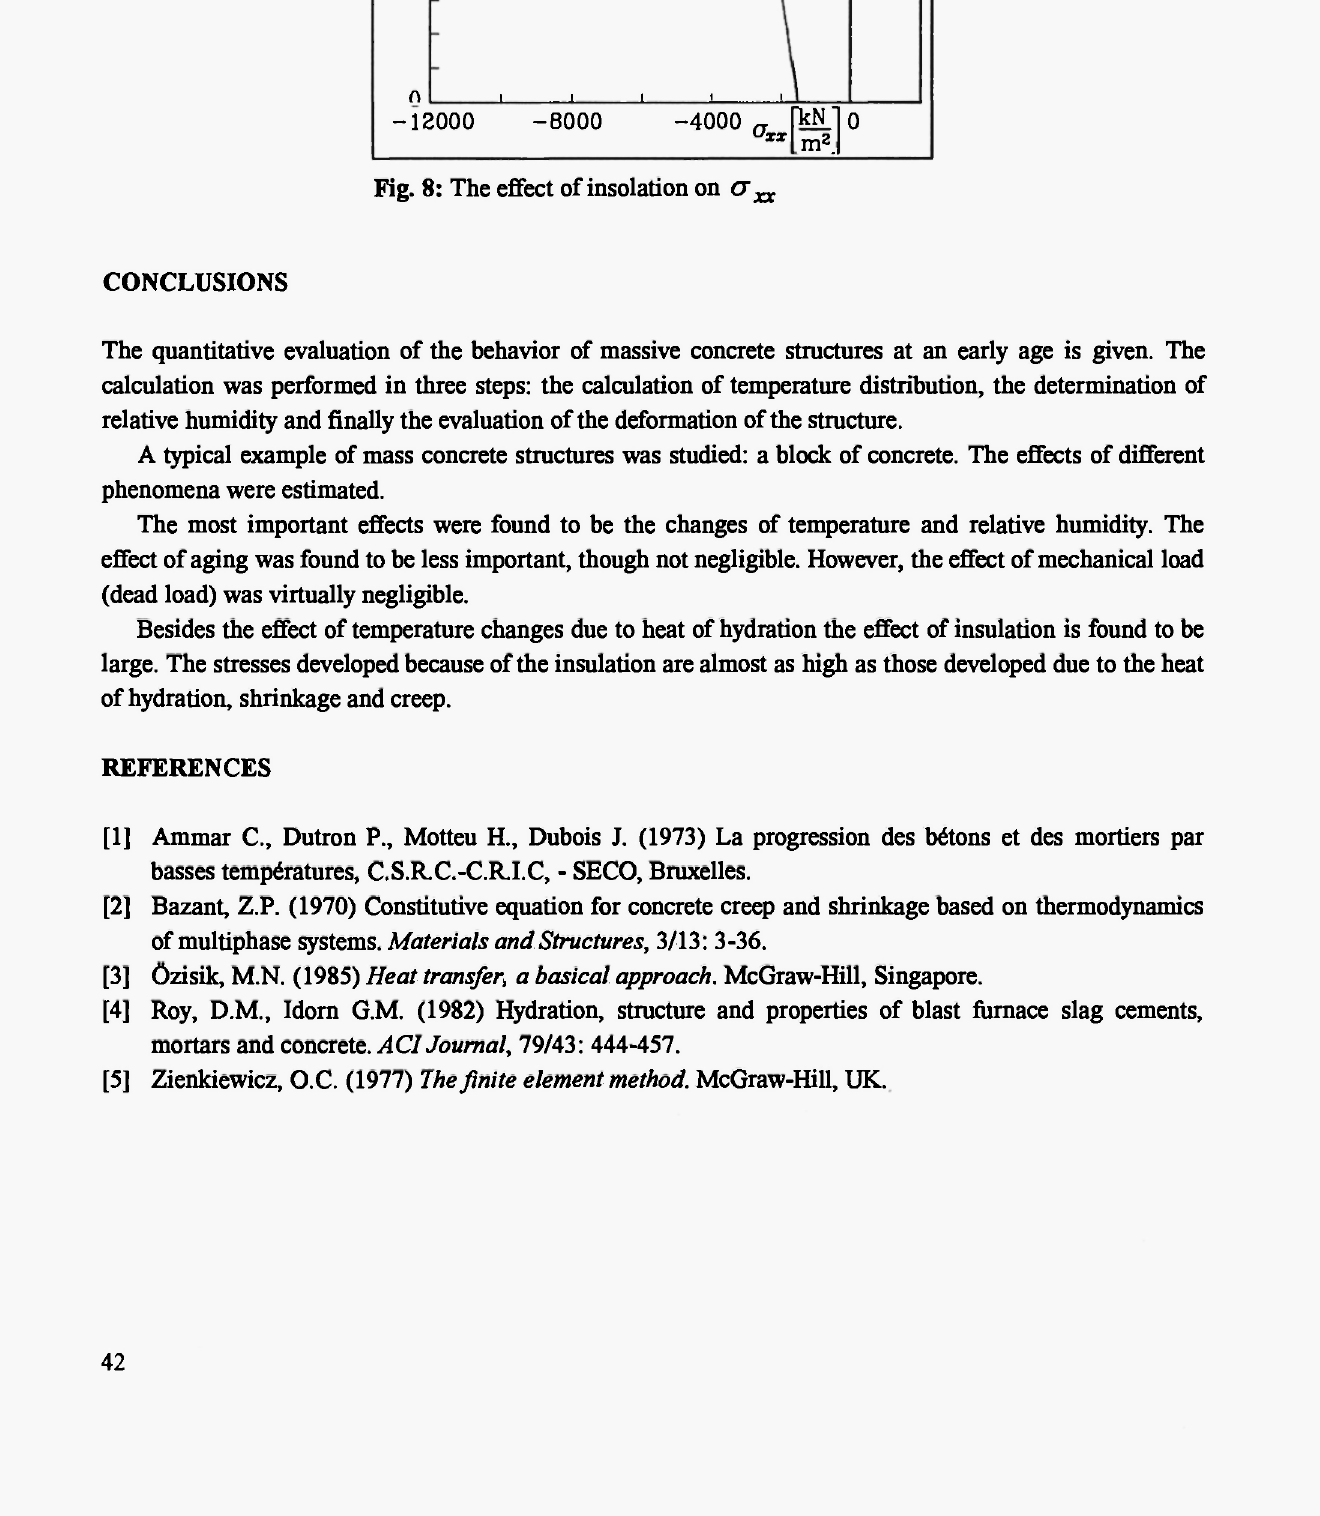
Fig. 8: The effect of insolation on